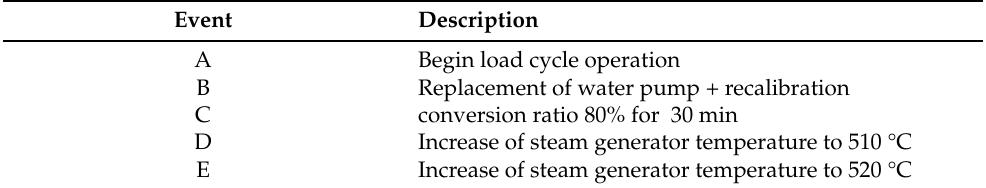
Table 3. Events at stack